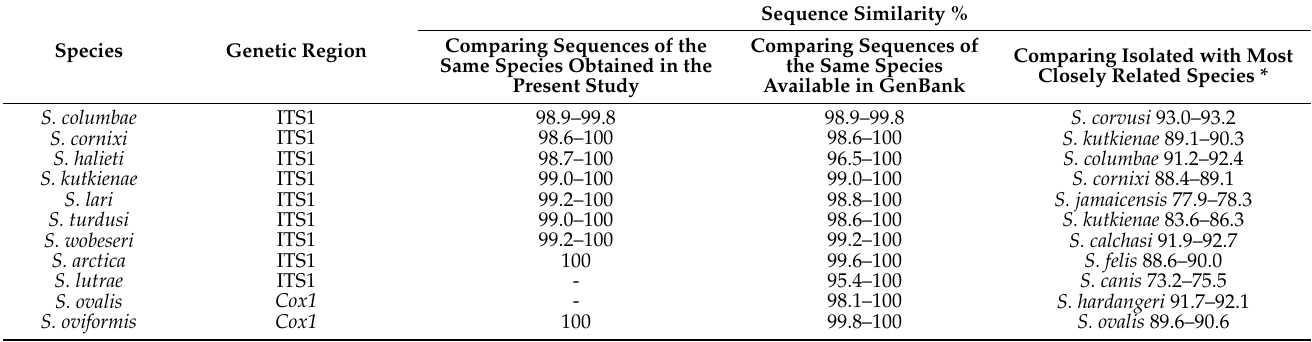
Table 3. Identification and genetic variation of detected Sarcocystis